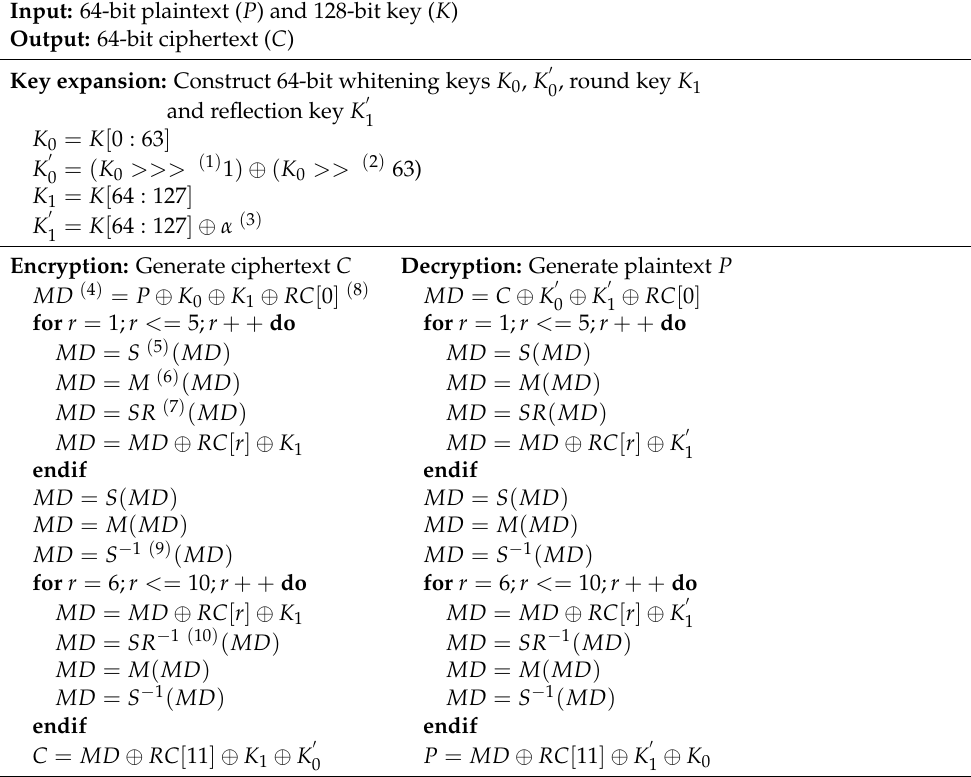
Table 1. Algorithm flow of